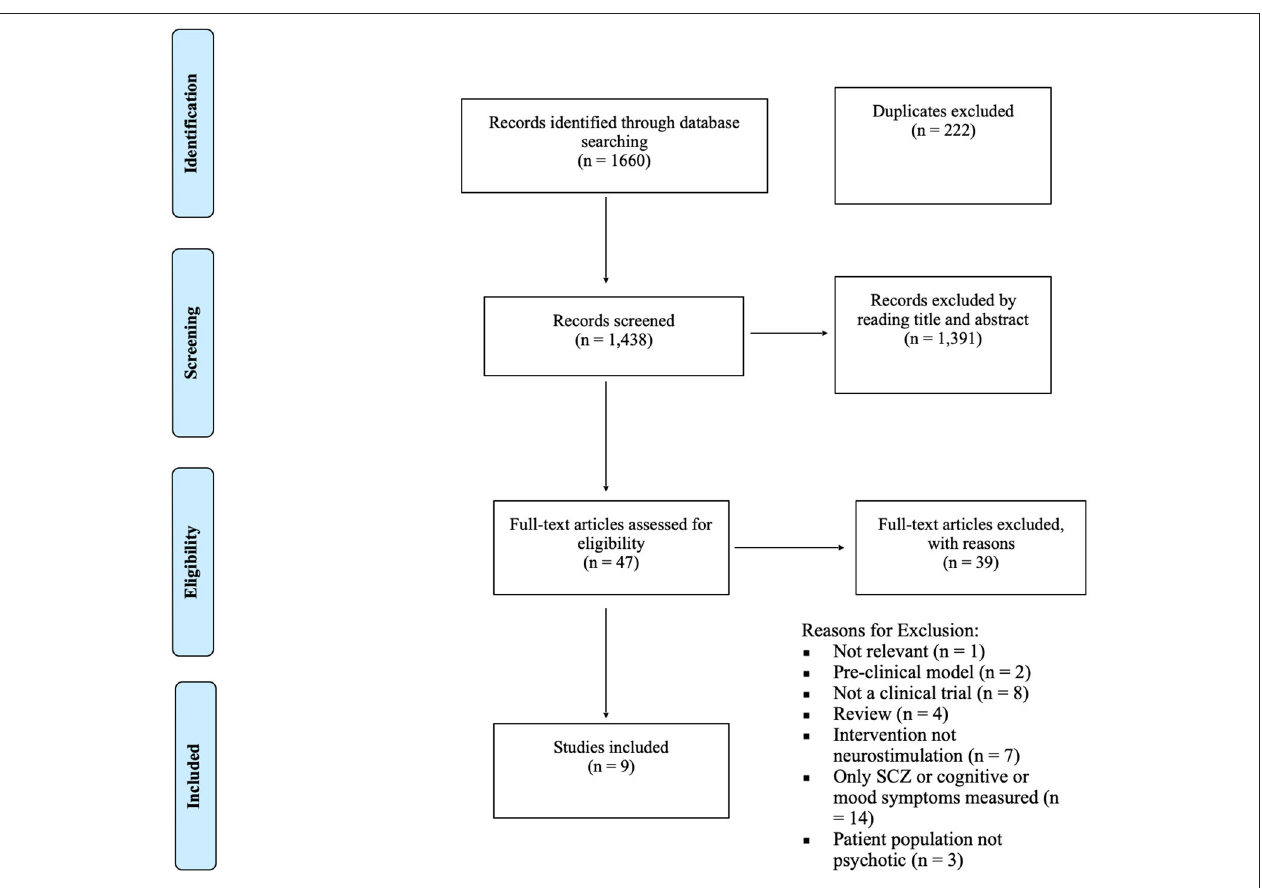
FIGURE 1 | PRISM-A diagram depicting study inclusion process (51).